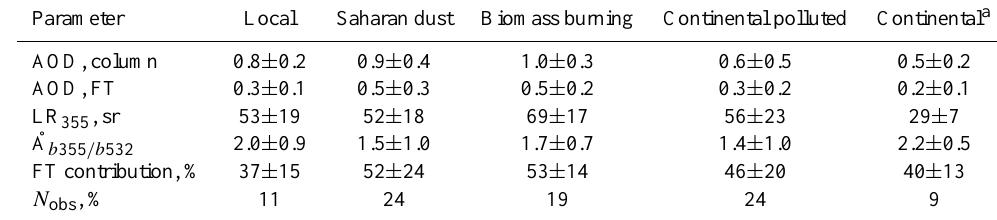
Fig. 3, based on the preceding classification of the aerosol types. Error bars stand for the standard deviations of the vertical averaging. Figure 3a presents the scatter plot for Saharan dust aerosols. The correlation coefficient between the ˚Angstr¨om exponent and the lidar ratio is − 0.61,